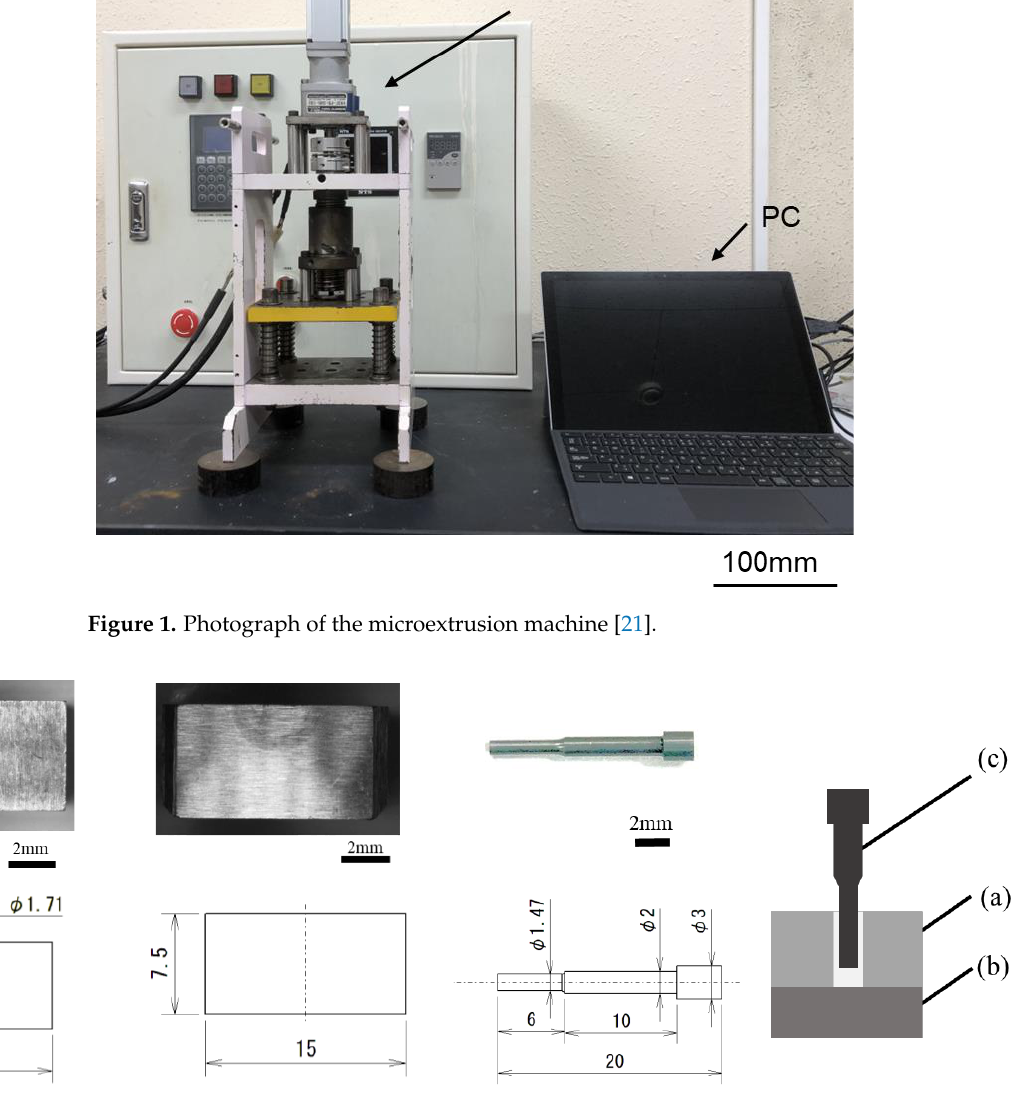
Figure 2. Shape of the die and punch: ( a ) extrusion die, ( b ) jig, and ( c ) punch; ( d ) schematic of back- ward microextrusion [21].